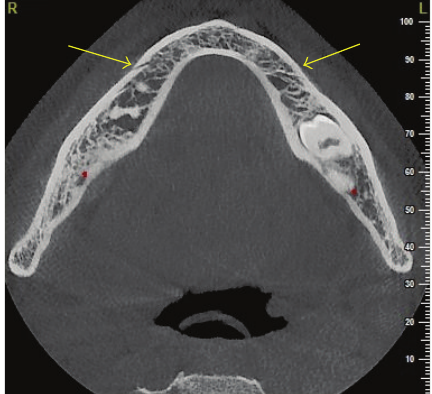
Figure 3: Transverse CBCT slice of the right MF is pointed by the arrow and the left MF area protuberance is pointed by the